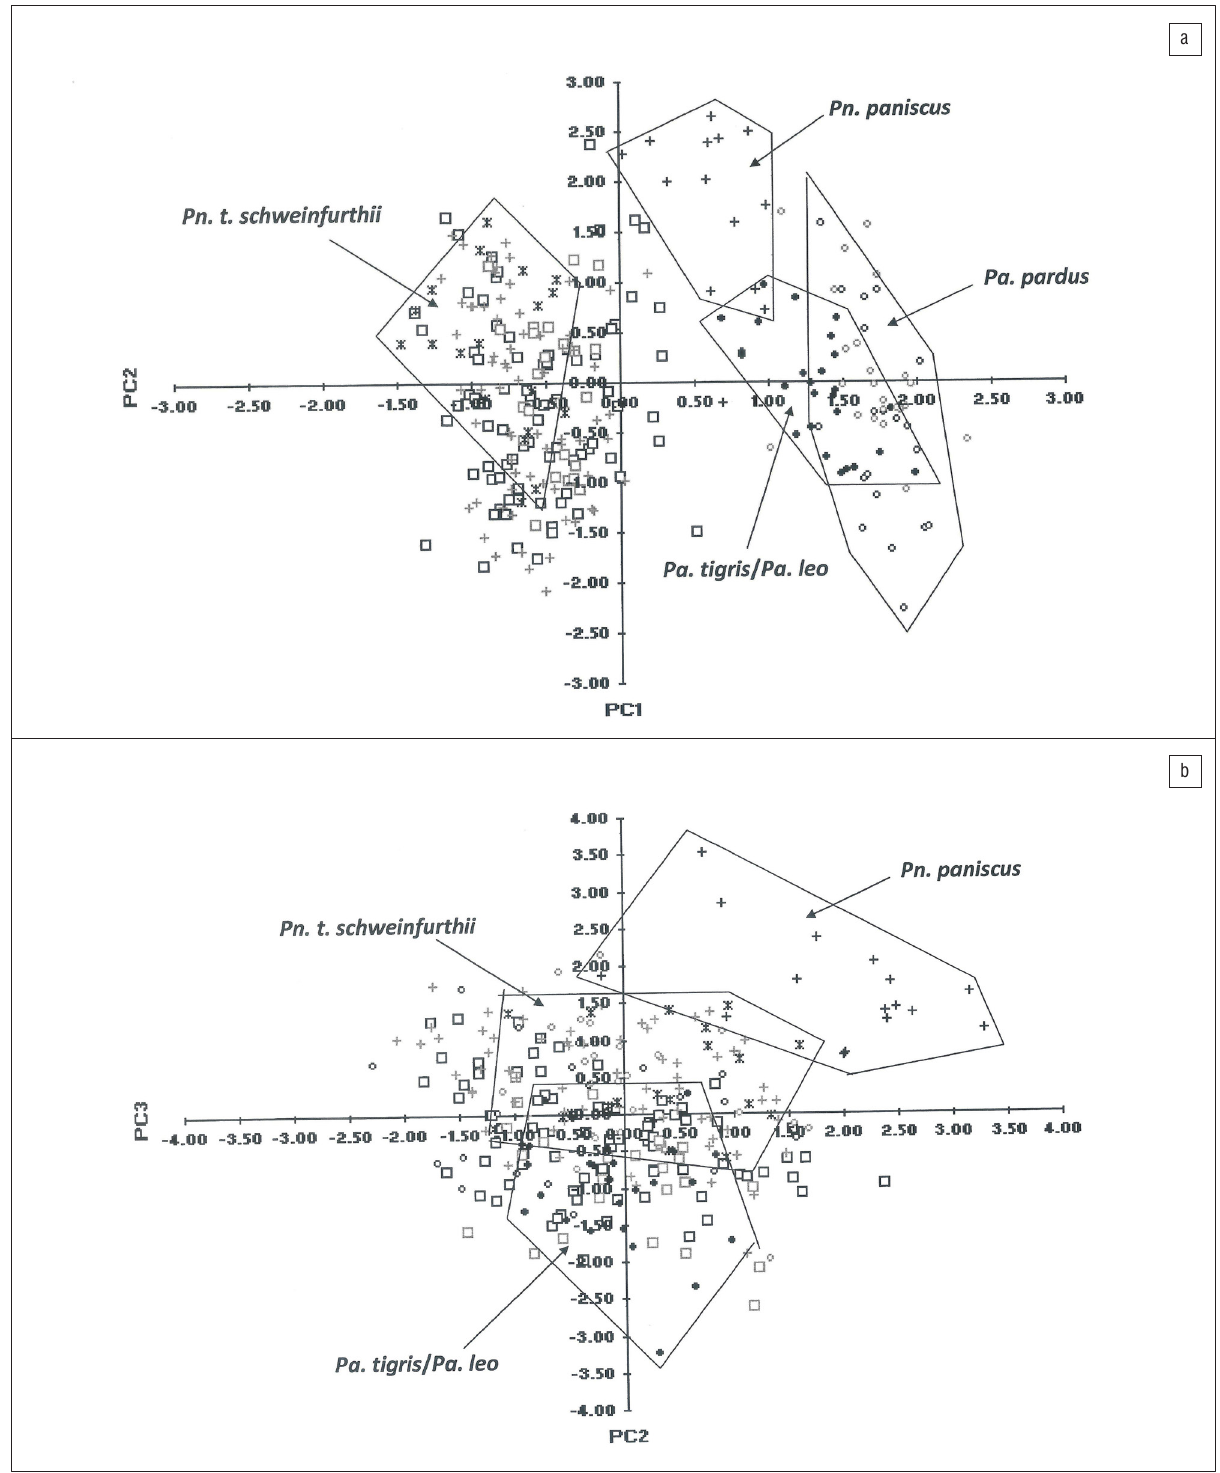
Open black squares, Gorilla g. gorilla; open grey squares, G. b. graueri/G. b. beringei; black crosses, Pan paniscus; grey crosses, Pn. t. troglodytes; black asterisks, Pn. t. schweinfurthii; filled black circles, Panthera tigris/Pa. leo; open black circles, Pa. pardus; open grey circles, Acinonyx jubatus. Figure 3: Principal components (PC) analysis of the pooled sample Mosimann shape data: (a) PC2 to PC1 and (b) PC3 to